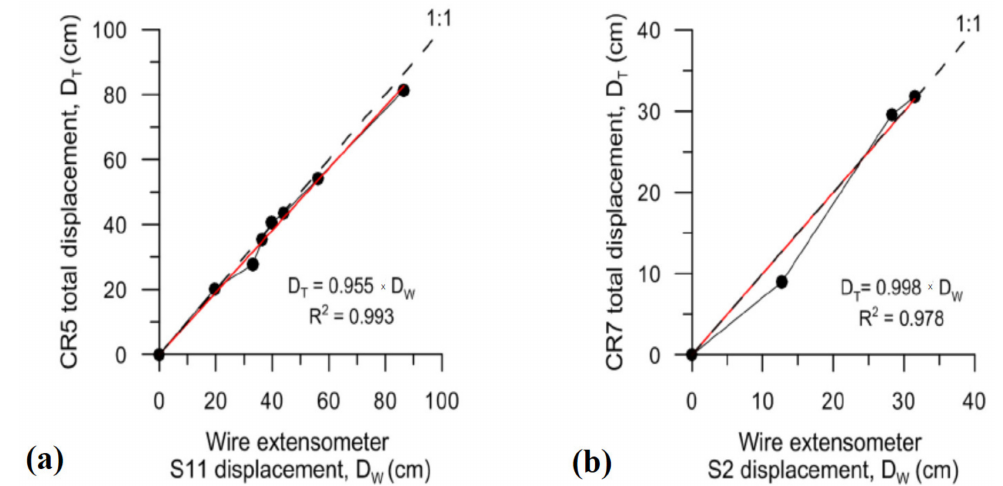
Figure 26. Charts showing GBSAR total displacement, D T , against wire extensometer displacement, D W : ( a ) for CR5 and S11, and ( b ) for CR7 and S2.